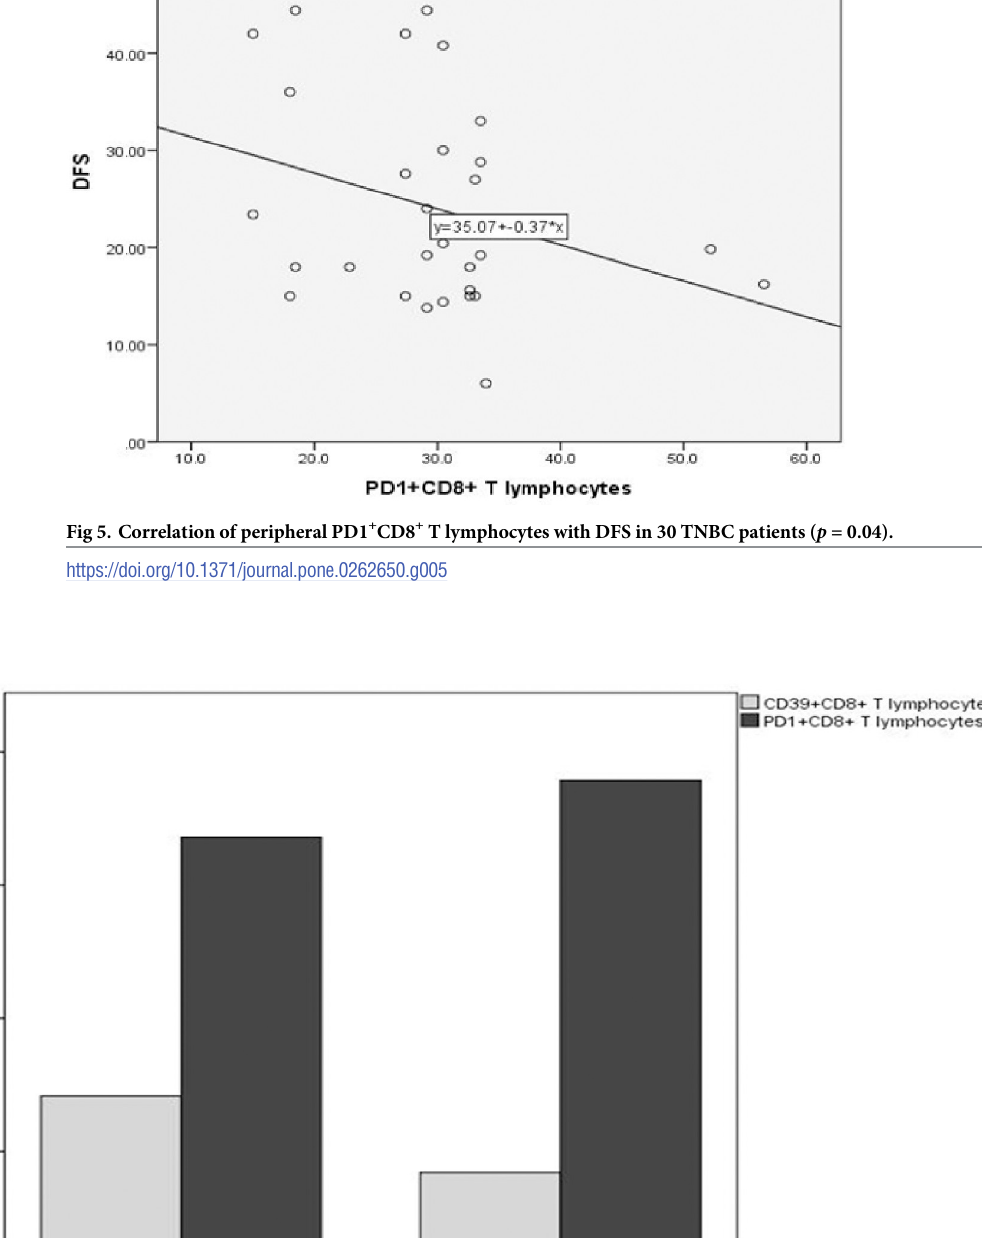
PLOS ONE | https://doi.org/10.1371/journal.pone.0262650 January 20,